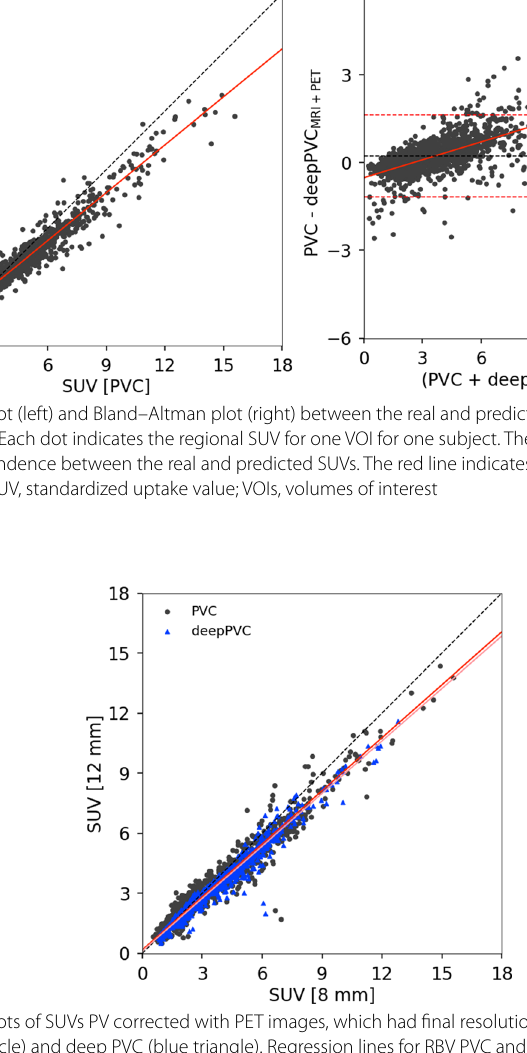
Test with misaligned PET images We observed trends of significantly lower or equal percentage differences in PV-cor- rected SUV for deepPVC versus RBV PVC (Fig. 8 and Additional file 1: Fig. S4). Sig- nificantly higher percentage differences were observed for deepPVC versus RBV PVC in some regions and directions: 24/132 directions (132 directions directions/region).